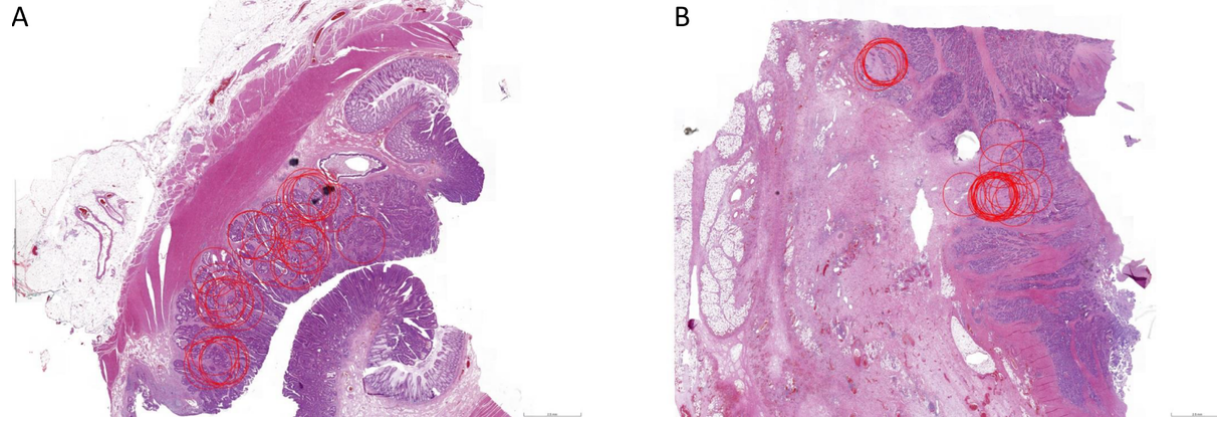
Figure 5. Examples of the distribution of annotations. In stroma-low cases (A), a wide distribution was more frequent, whereas in stroma-high cases, a hotspot (or sometimes more) formed